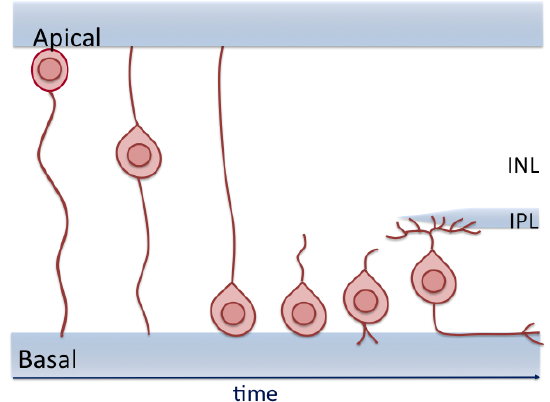
Figure 4. The newborn retinal ganglion cell (RGC) translocates from the apical part of the retina toward the future ganglion cell layer at the basal side. During the entire process, the cell is attached to both sides of the retina. After the migration, the RGC adjusts its position while losing its apical process and send its axon to the optic nerve. INL: inner nuclear layer, IPL: inner plexiform layer. Adapted from Amini et al. [159].